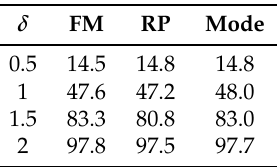
Table 7. Power of the control chart, 1 − β , for the case M 1 (Equation (5)) model in the scenario of independence between curves.